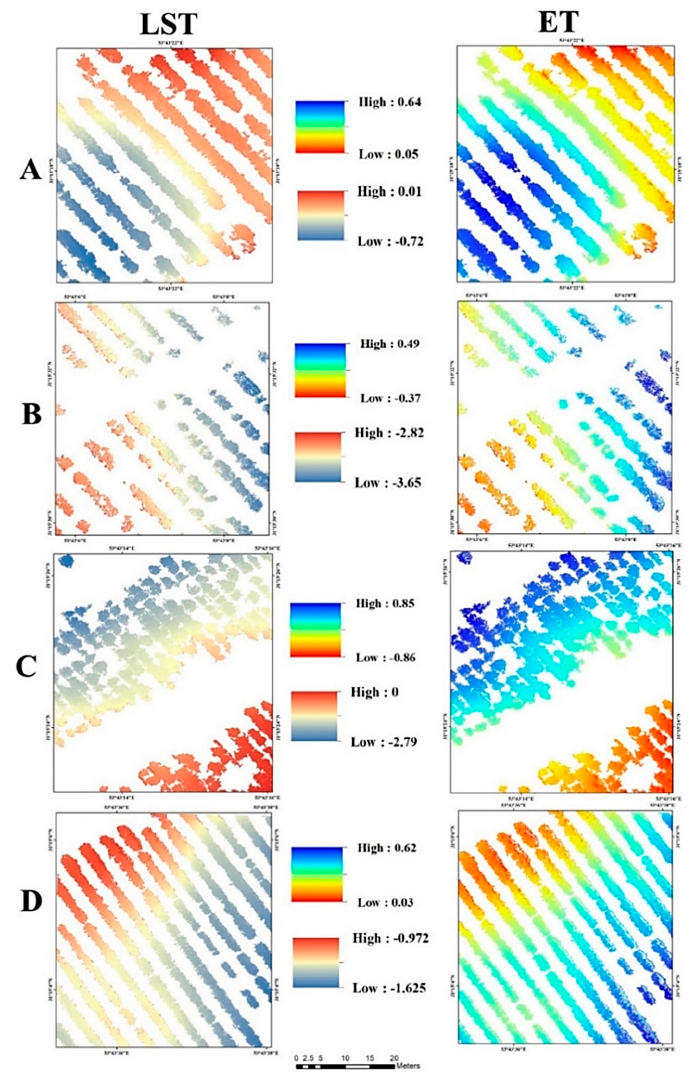
Figure 10. Changes in pistachio tree temperature (LST, °C) and daily evapotranspiration (ET, mm/day) after foliar application of gypsum in plot ( A ) and of gypsum again, gypsum, NAX-95 (Calcium-Based Suspension Coating), and sulfur in plots ( A ), ( B ), ( C ), and ( D ), respectively. The maximum, minimum, and mean pistachio tree temperature and daily evapotran- spiration difference between the first and second imaging dates are shown in Table 3.